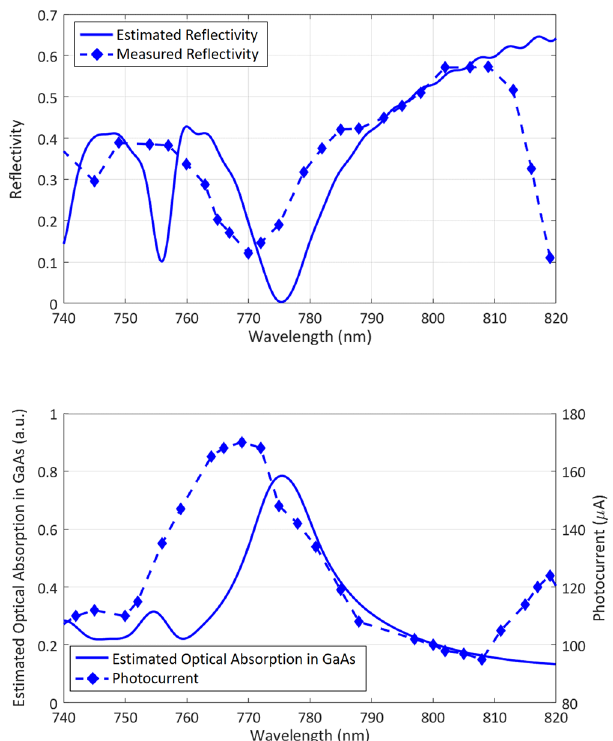
Figure 4. ( a ) The estimated and measured optical reflectivities of the plasmonic nanoantennas as a function of the wavelength. ( b ) The estimated optical absorption in the top GaAs layer and the measured photocurrent in the terahertz source